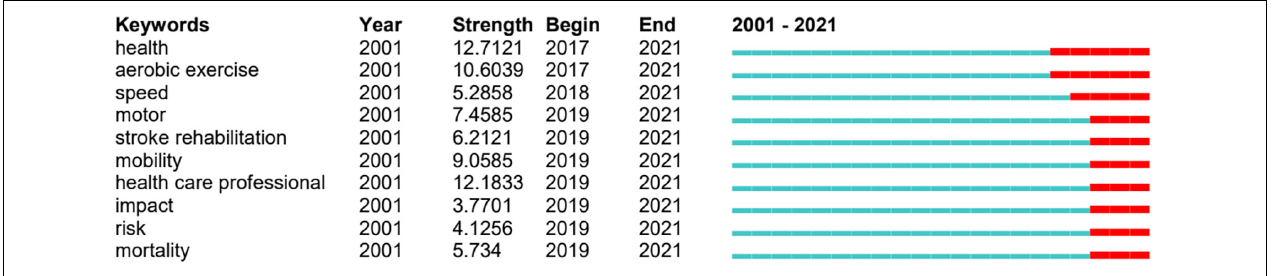
FIGURE 7 | Burst keywords with frequent citations until 2021.